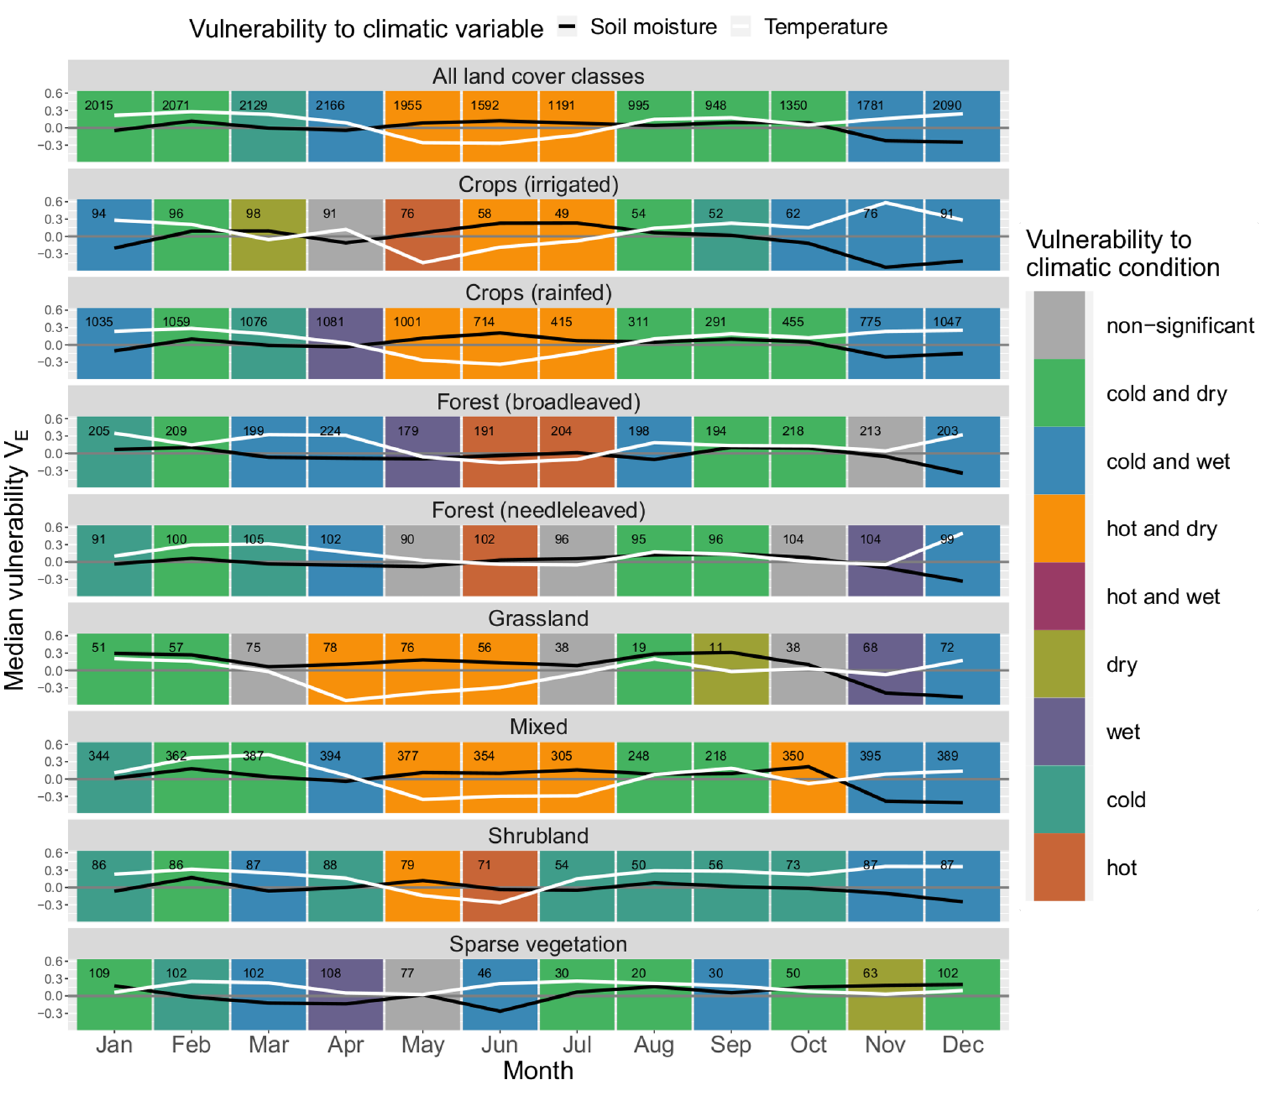
Figure A1. Median monthly ecosystem vulnerability per land cover. Vulnerability to temperature (ERA5-Land) is shown in white, and vulnerability to soil moisture (ERA5-Land at depth 0–7cm) is shown in black for each month of the year (columns) for each land cover (rows). Months with statistically significant deviation in climatic drivers during non-hazardous and hazardous ecosystem conditions according to the Mann–Whitney U test based on a significance level α = 0 . 05 are shown in colour (see legend); all other months are shown in grey. The number of grid points in which an event has occurred in this month and land cover within the period 1999–2019 is shown in the upper left corner of each